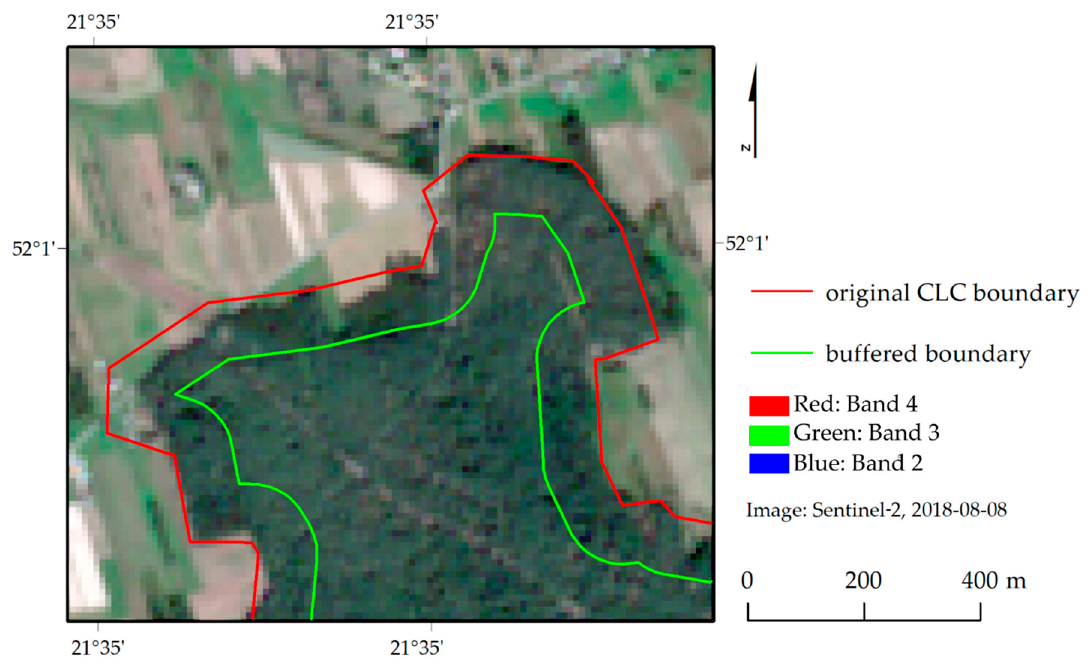
Figure 5. Buffering of original Corine LC polygons .